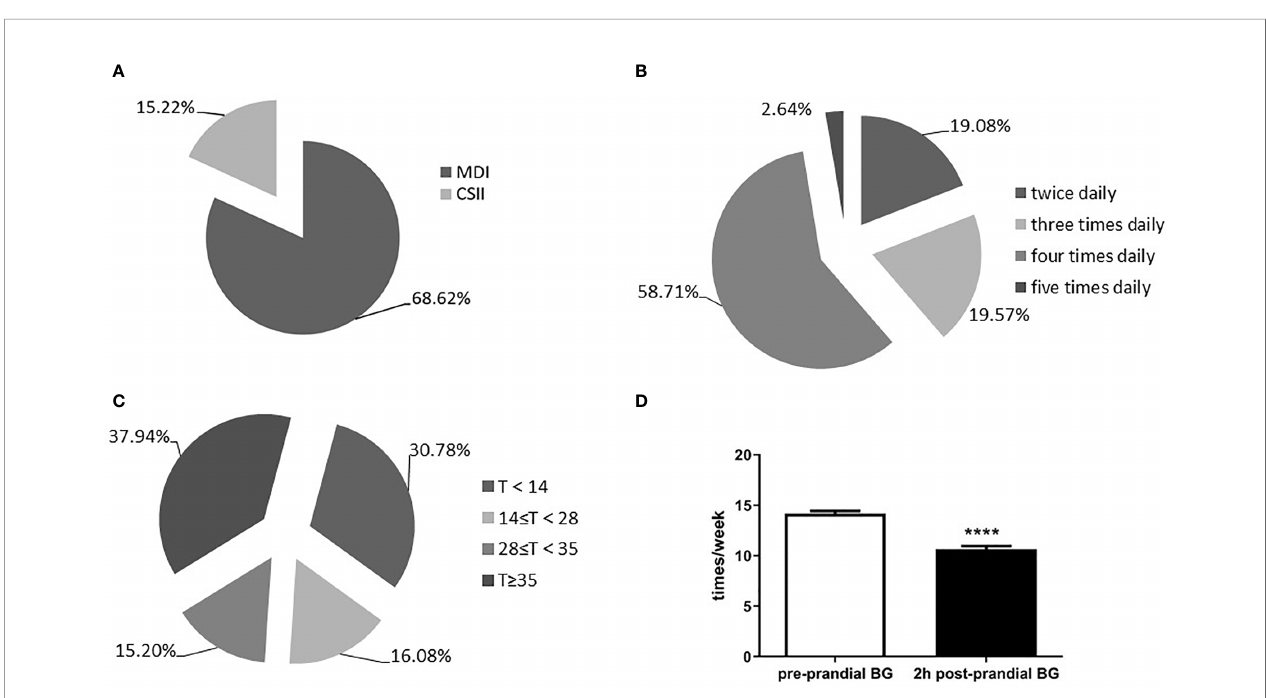
FIGURE 2 | Insulin injection and blood glucose monitoring. (A) Intensive insulin injection scheme; (B) Proportion of different daily insulin subcutaneous injection programmes; (C) Times of self-monitoring of blood glucose per week; (D) Comparision of blood glucose monitoring times between pre-prandial blood glucose and 2h-post prandial blood glucose. MDI, multiple daily subcutaneous injections; CSII, continuous subcutaneous insulin infusion; T, times of self-monitoring of blood glucose ****p <